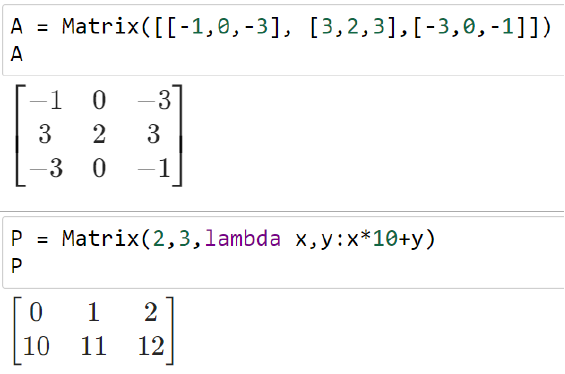
Figure 8. Matrix definition.